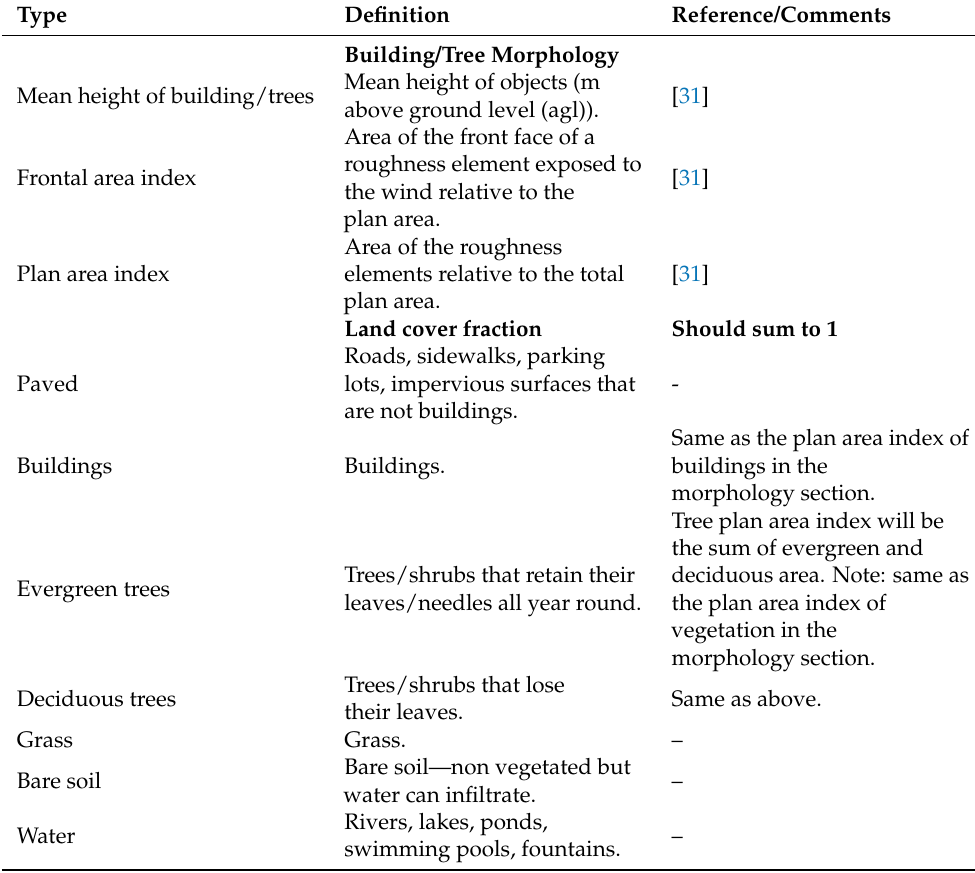
Table 3. Spatial data requirements for SUEWS